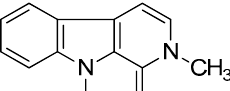
Figure 3. Structure of canthine 40 .